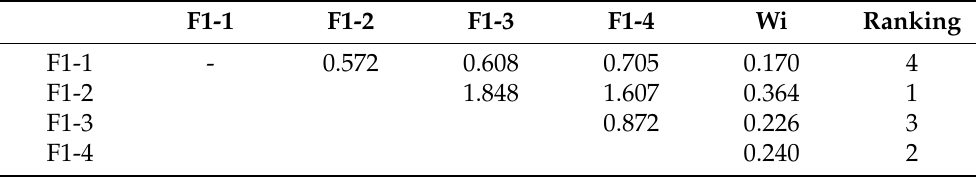
Table 8. Ranking of secondary factors in “green product